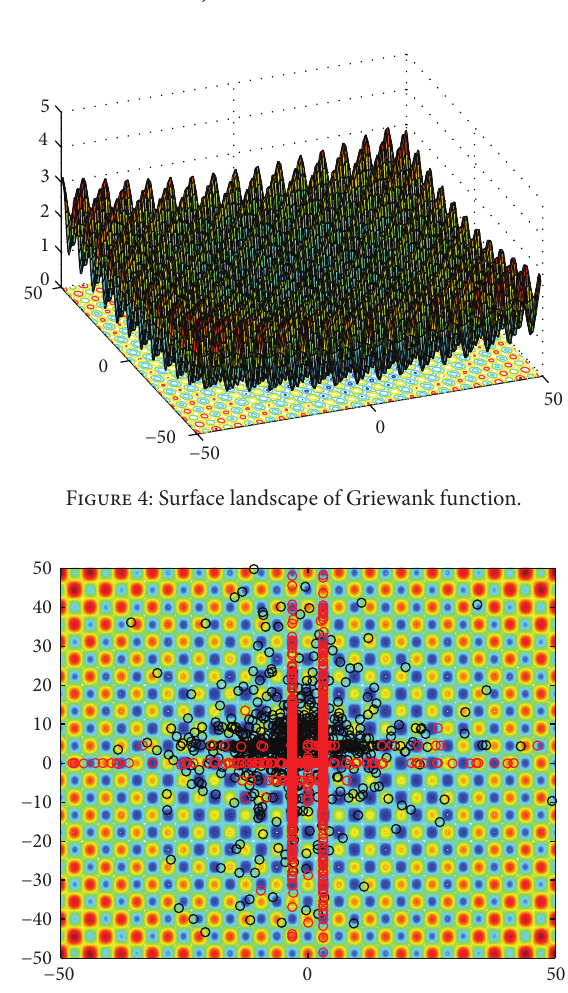
Figure 5: Particles in QPSO and CQPSO-DVSA-LFD.